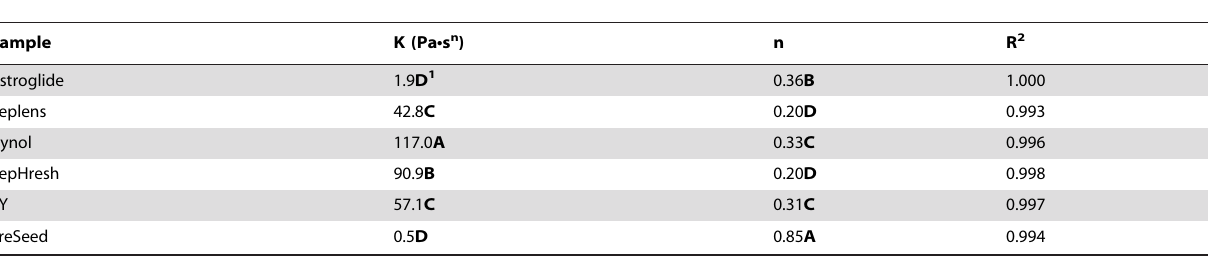
Table 4. Flow behavior